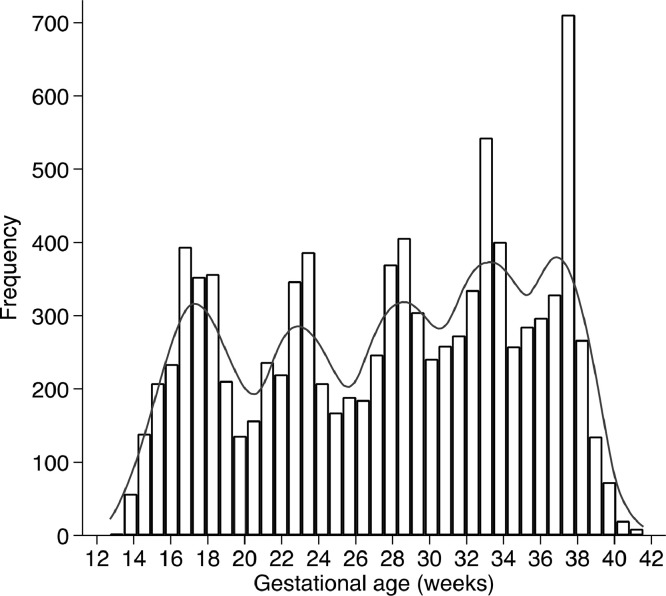
Distribution of gestational ages at which haemoglobin concentration was measured.